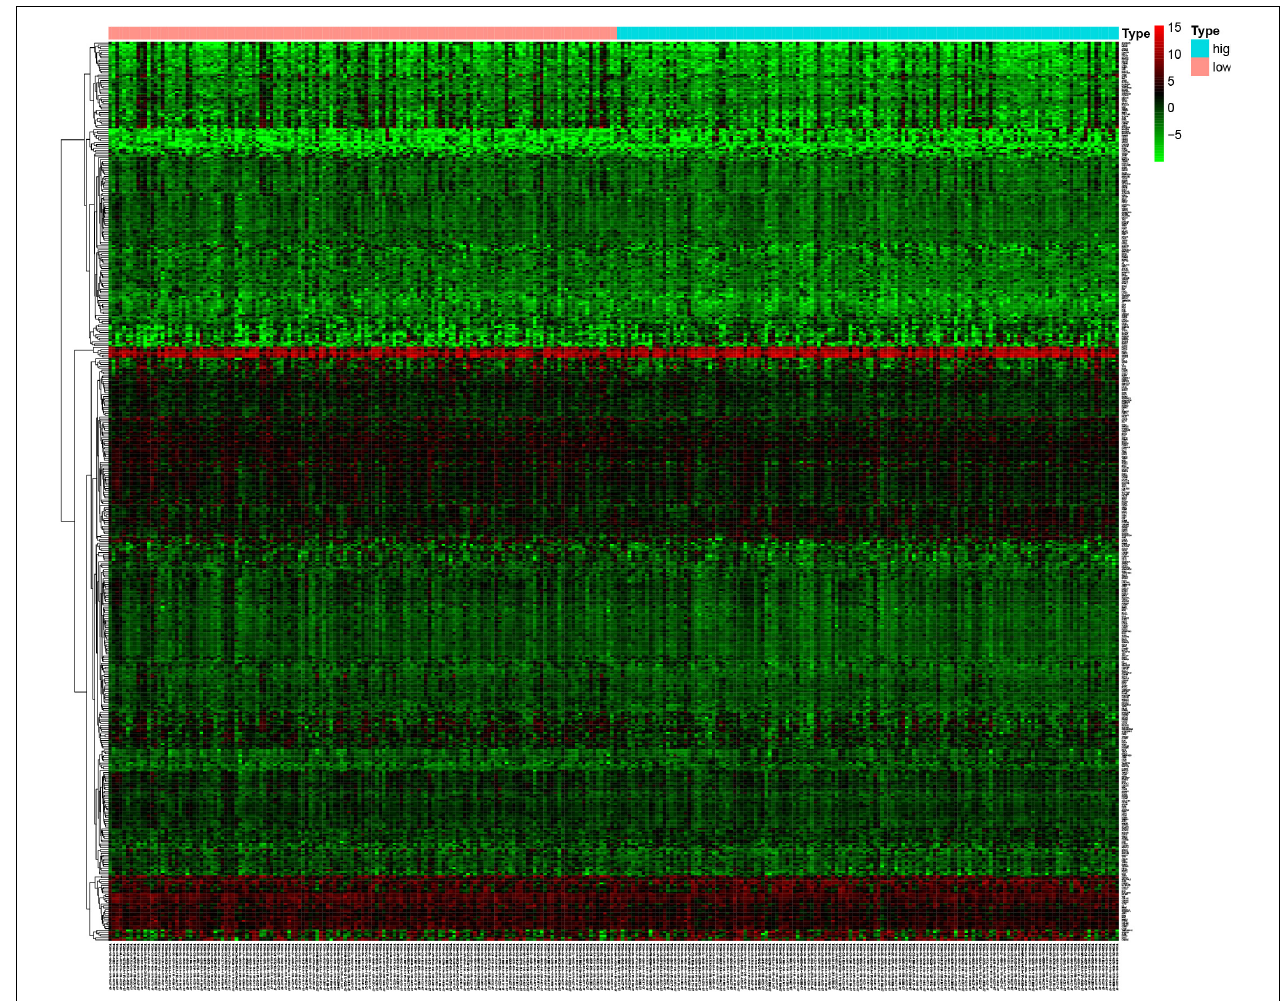
FIGURE 3 | The mutant genes with higher expression in the heatmap are shown in red, lower expression in green, and genes with the same expression level in black. The heatmap of the DEG of the left half (low-TMB subtypes) and the right half (high-TMB subtypes) of TMB. DEG, differentially expressed gene. TMB, mutant tumor